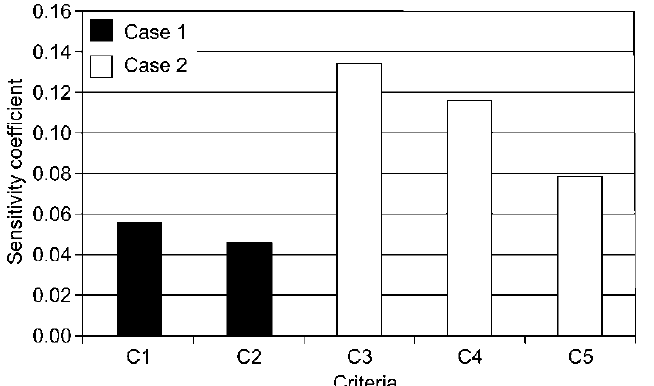
Figure 8. Variability of the sensitivity coefficient for each criterion for the two